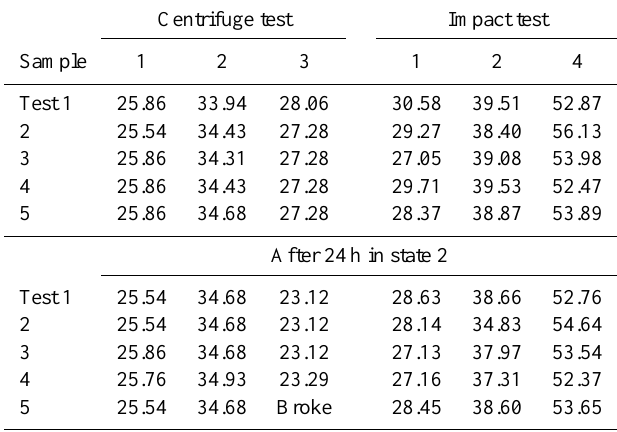
Table 4. Threshold acceleration test results for 14 ◦ configuration, reported in g’s.